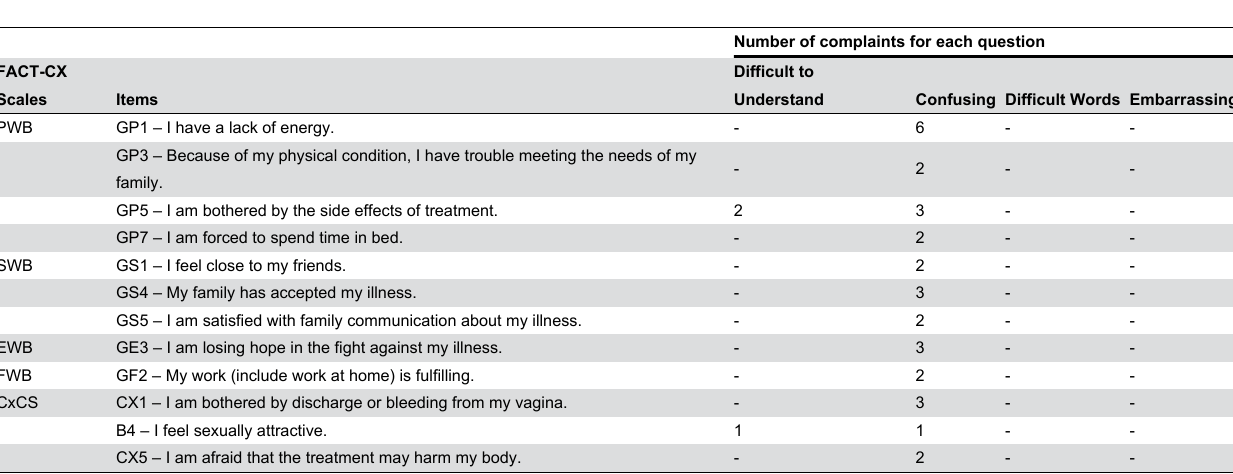
Table 2. Number of respondents who reported some complaint concerning the FACT-CX questionnaire, as determined in their evaluation of the level of understanding of each question.